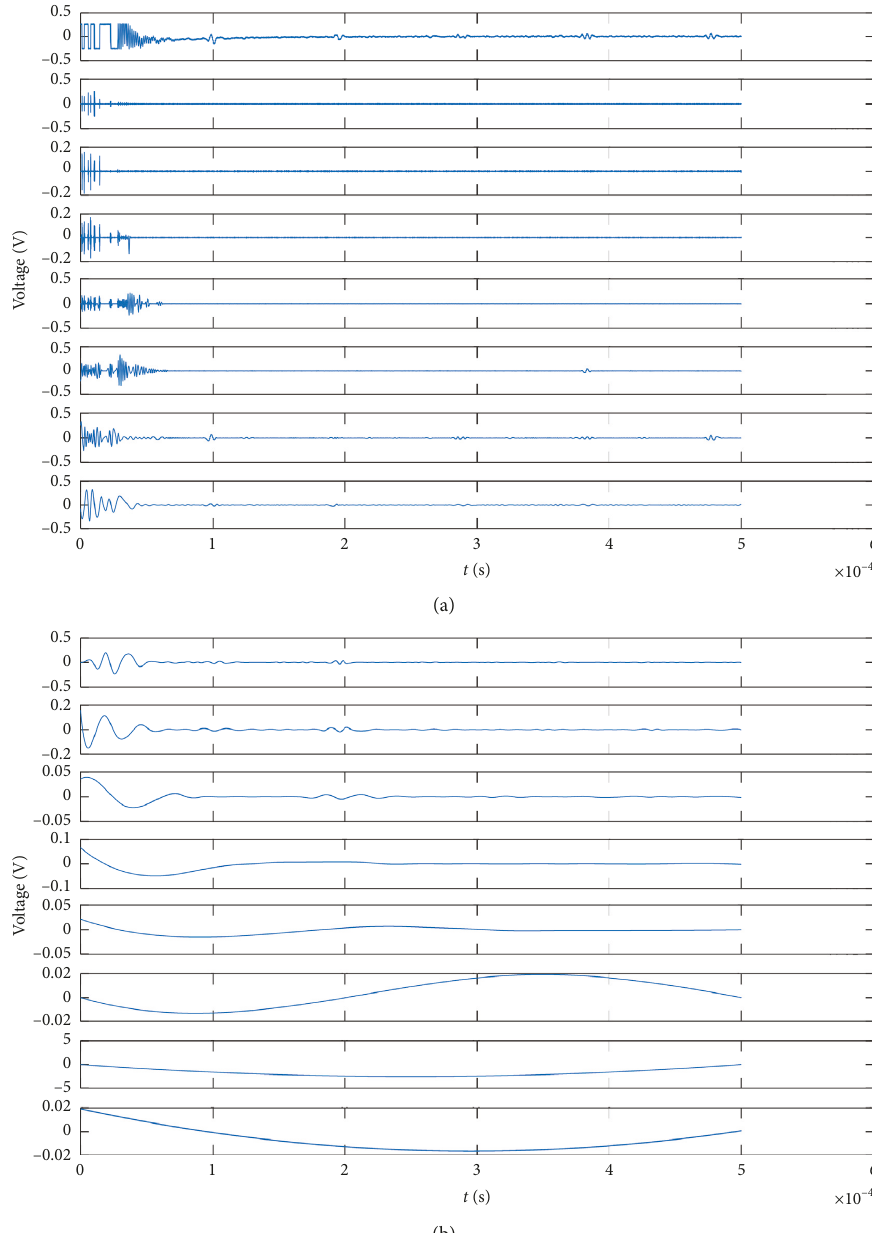
Figure 2: Decomposition results of EEMD method. (a) IMF 1–8. (b) IMF